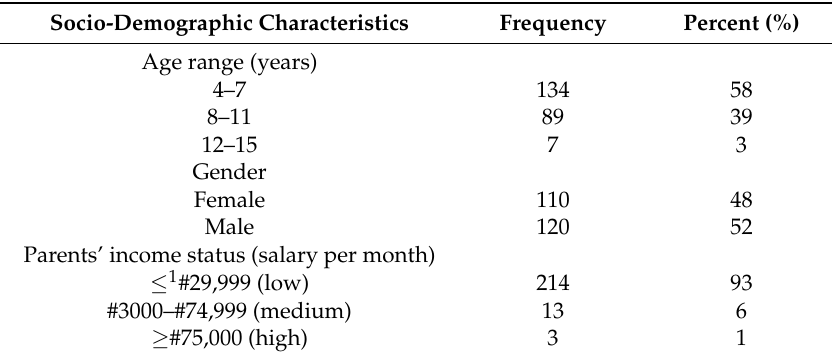
Table 1. Socio-demographic characteristics of the participants.